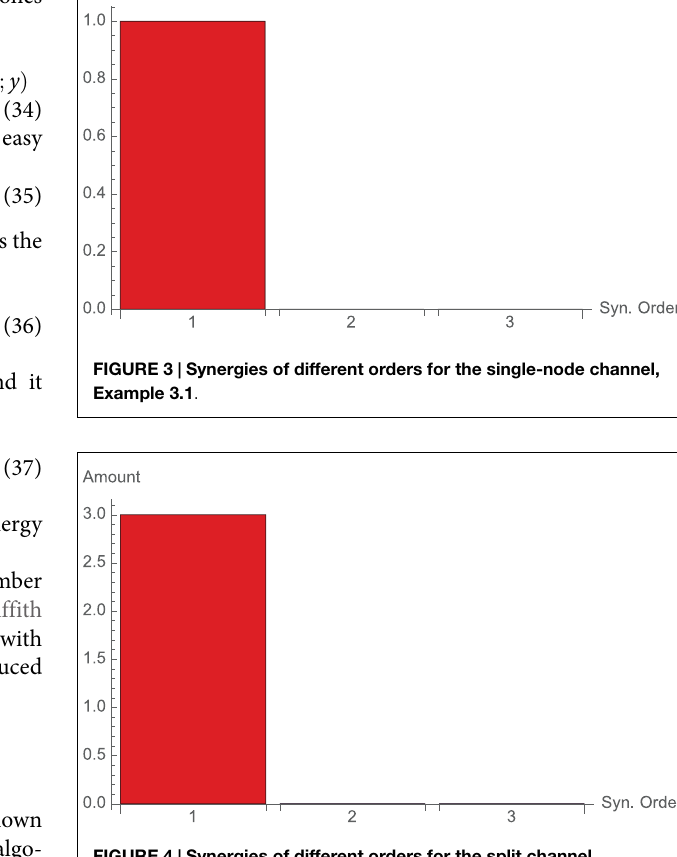
FIGURE 4 | Synergies of different orders for the split channel, Example 3.2